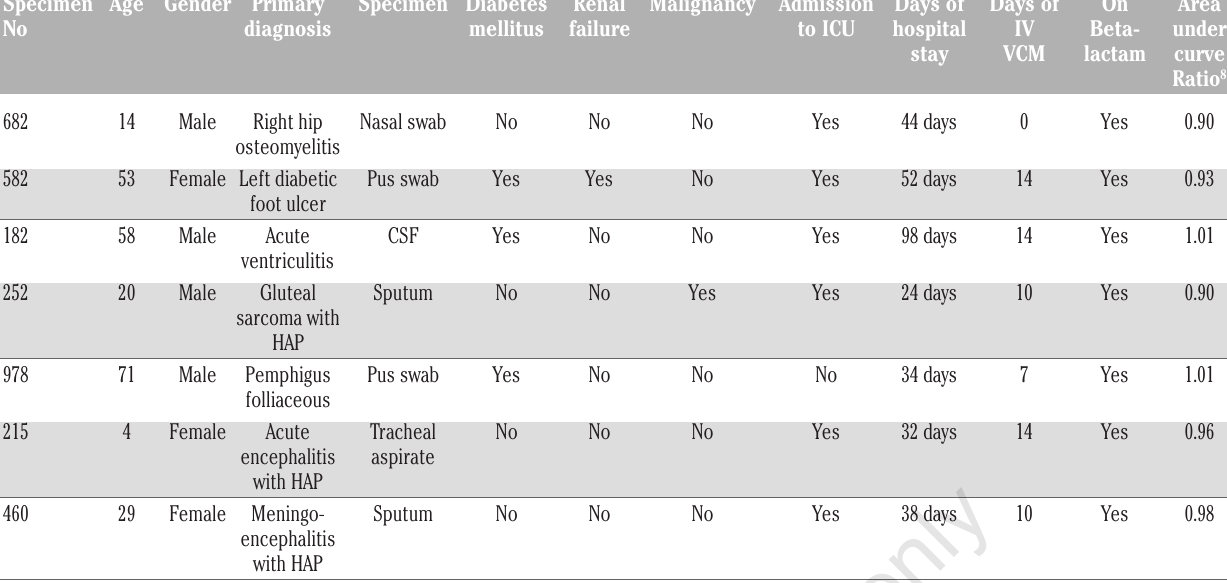
Table 1. Heterogenous vancomycin intermediate Staphylococcus aureus strains and their corresponding patients in this study. Specimen Age Gender Primary Specimen